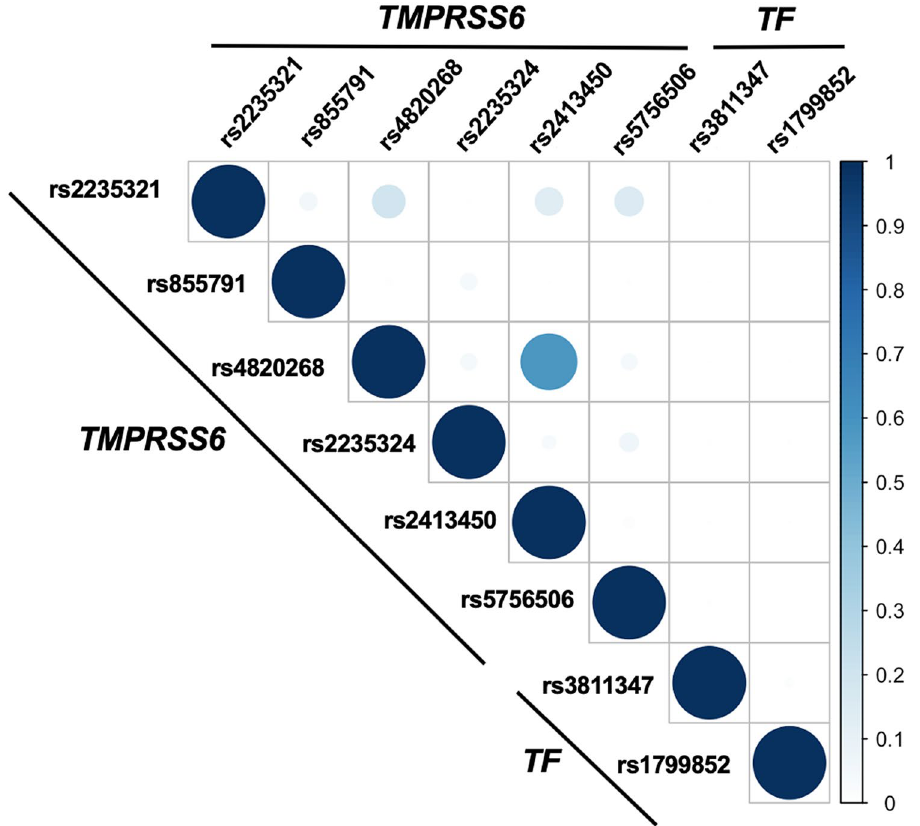
Figure 1. Linkage disequilibrium analysis between SNPs investigated in this